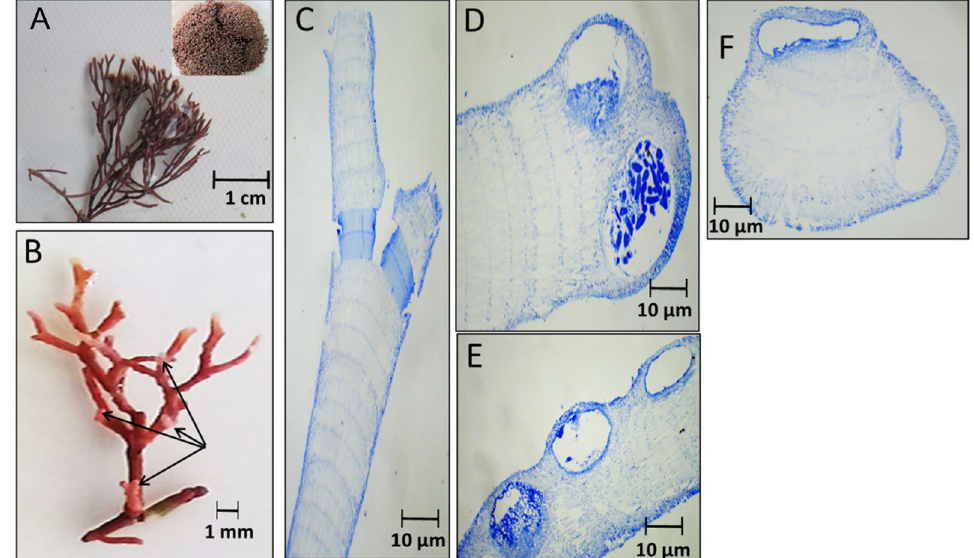
Fig. 9 Morphological and anatomical description of Amphiroa rigida during summer 2020. A Habit view of thallus, B Magnification of the thallus frond, C L. S. in thallus showing genicula and intergenicula tiers, D Magnification of mature tetrasporangium at thallus tips, E Mature tetrasporangium at thallus peripherals of the intergeniculum, F Cross-section through intergeniculum